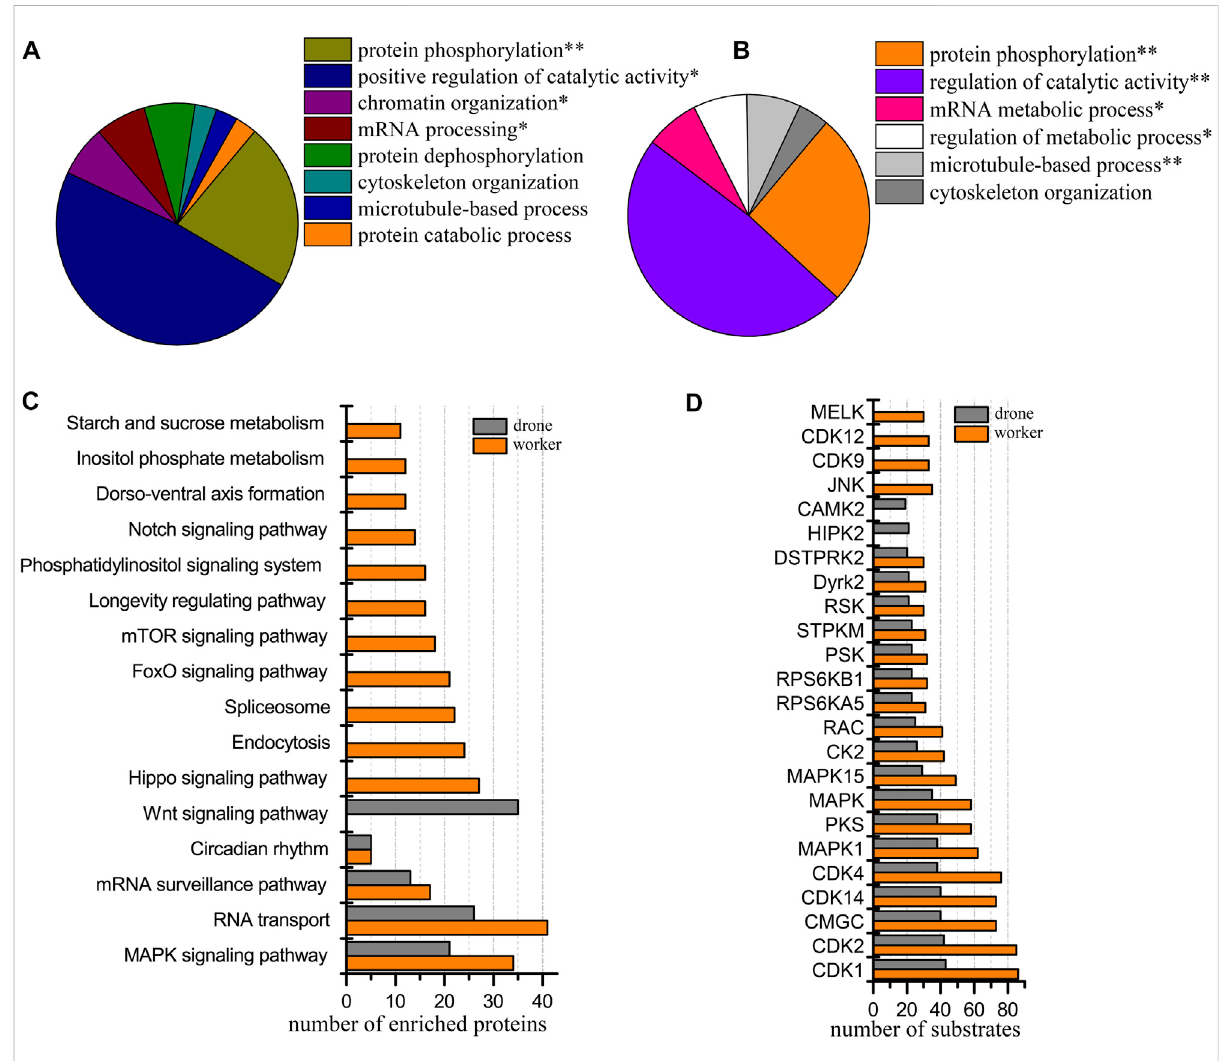
Comparison of the phosphoproteins identi fi ed in worker and drone embryos at 48 h. (A) ClueGO analysis of the phosphoproteins identi fi ed in 48 h worker embryos. (B) ClueGO analysis of the phosphoproteins identi fi ed in 48 h drone embryos. (C) Comparison of the biological pathways enriched in worker and drone embryo at 48 h. (D) Comparison of the kinase activity between the embryogenesis of worker and drone at 48